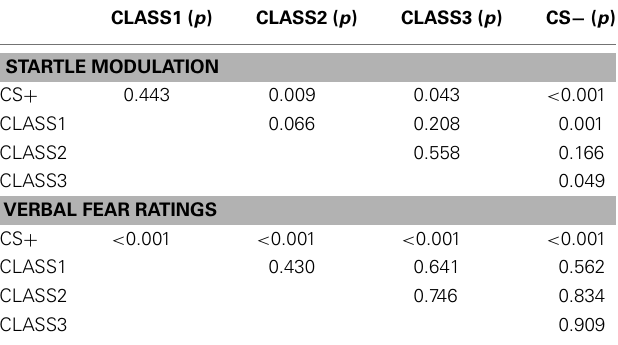
Table 2 | p -Values for the multiple comparisons using Fisher’s LSD test for the verbal fear ratings and the startle modulation for the predictable group during the first block of the generalization